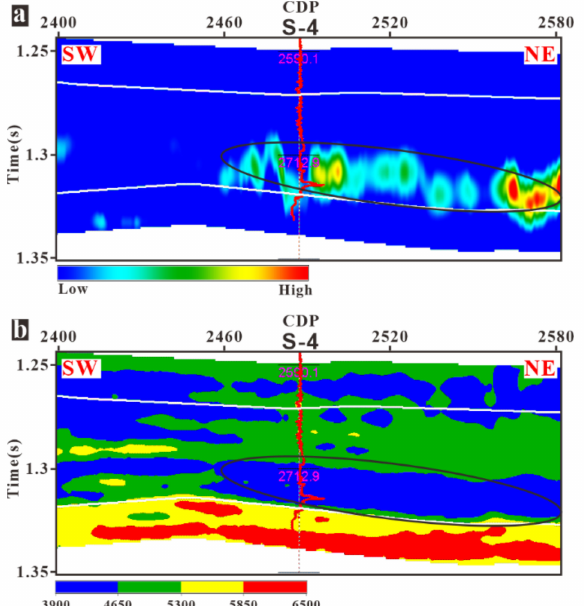
Figure 13. Seismic fluid mobility section ( a ) and inverted velocity (m/s) section ( b ) connecting gas well S-4. The two white lines are the top and bottom interfaces of Longmaxi Formation. The red curve near well S-4 is GR logging curve, and the pink scale is the vertical depth (m). SW and NE denote the southwest and northeast directions of the study area,